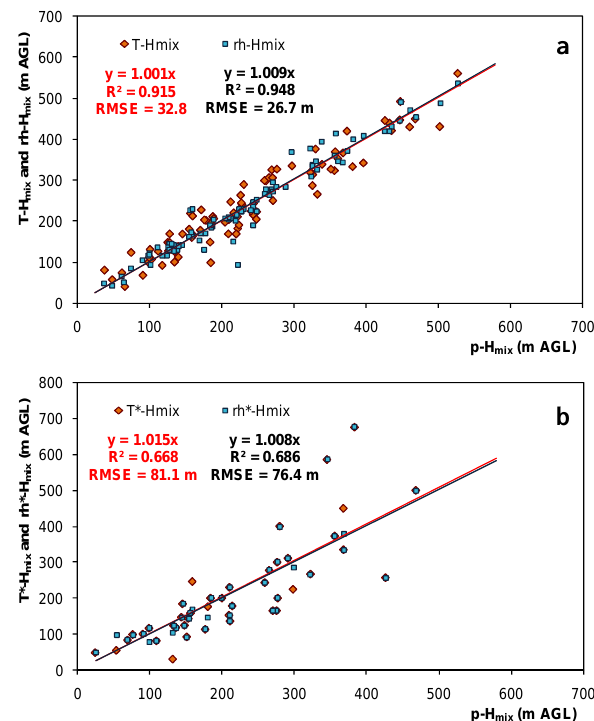
Fig. 3. (a) the correlation between the particle-derived mixing height ( p − H mix ) , and the temperature- and relative humidity- derived mixing heights (respectively T − H mix and rh-H mix ) es- timated from vertical profile measurements; (b) the correlation between the particle-derived mixing height ( p − H mix ) estimated from vertical profile measurements. and the temperature- and rela- tive humidity-derived mixing heights (respectively T ∗ − H mix and rh ∗ − H mix ) estimated from radiosoundings at Milano-Linate air-